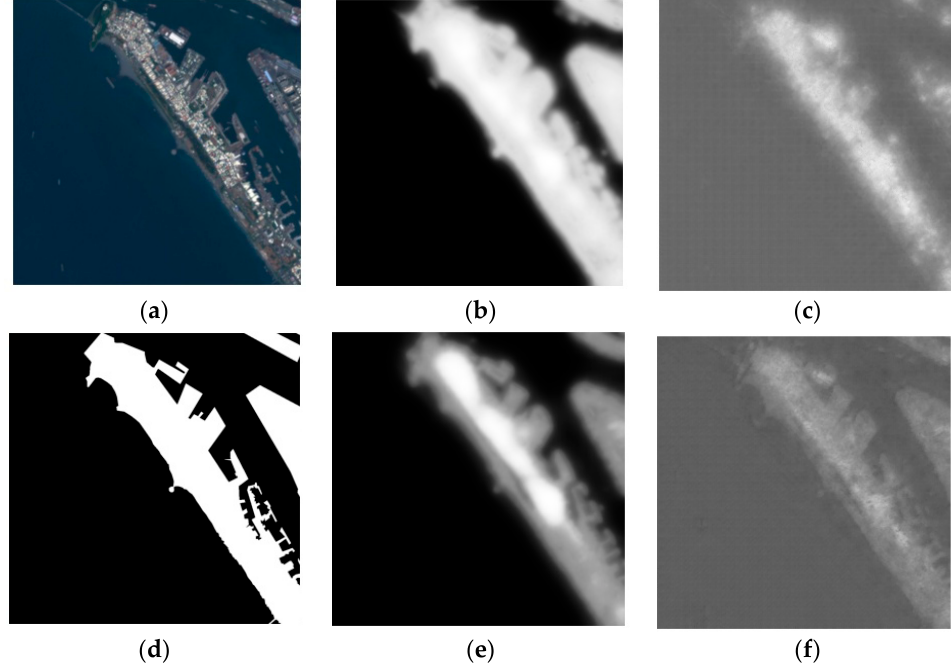
Figure 12. Sea–land segmentation results with different loss functions and optimizers: ( a ) RGB image; ( b ) BCE + Adam; ( c ) BCE + SGD; ( d ) Ground truth; ( e ) Focal loss + Adam; and ( f ) Focal loss + SGD.